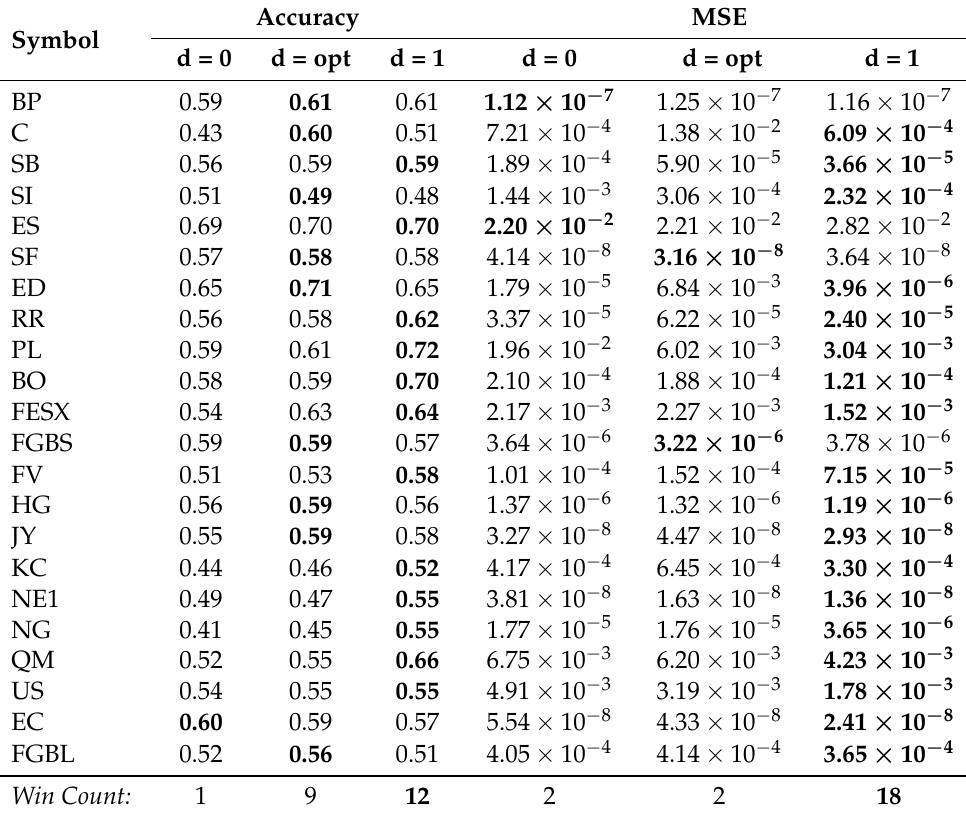
Table 3. Accuracy and MSE results of predicted true range